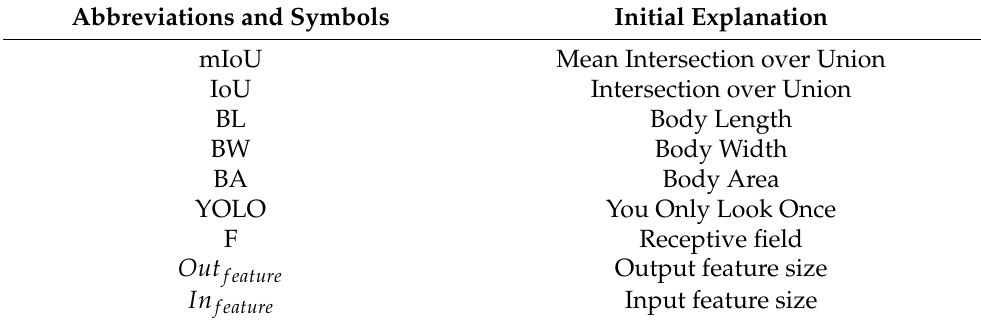
Table 1. Abbreviations and symbols. Abbreviations and